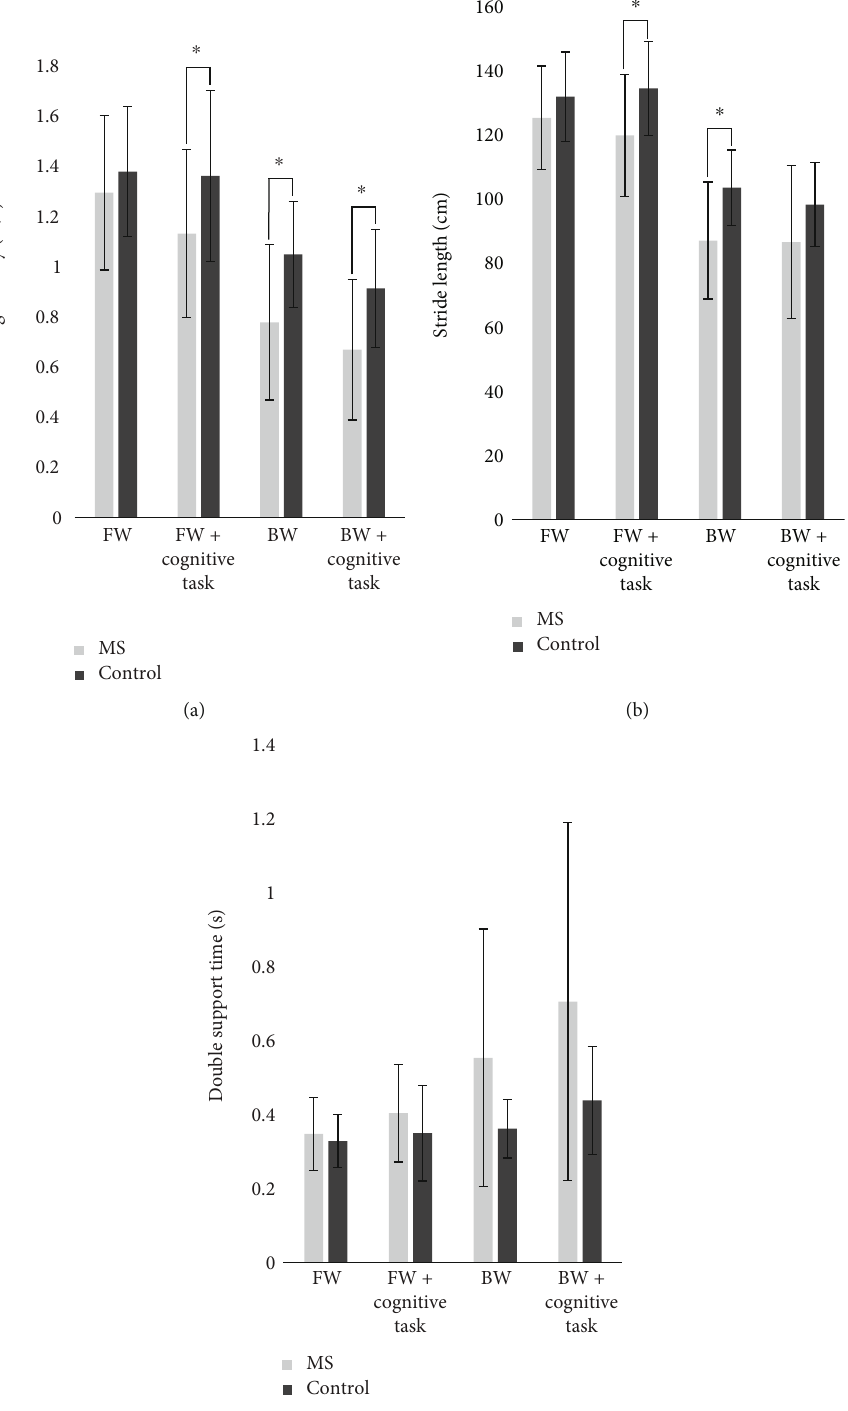
Figure 1: Walking velocity (a), stride length (b), and double support time (c) as a function of walking direction and group. ∗ indicates a signi fi cant di ff erence between MS and healthy controls ( p < 0 : 05